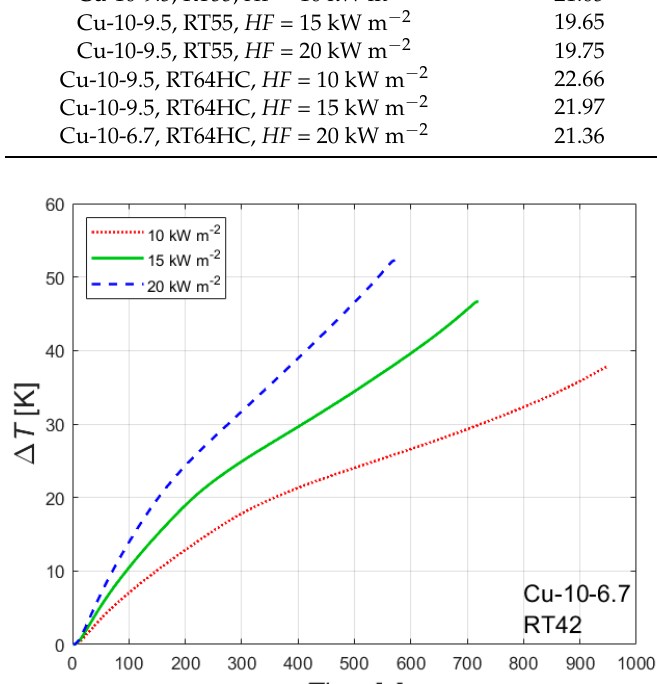
Figure 5. Effect of heat flux on the difference between wall and initial temperatures for the 10 PPI copper foam with a porosity of 0.933 with the paraffin RT42.